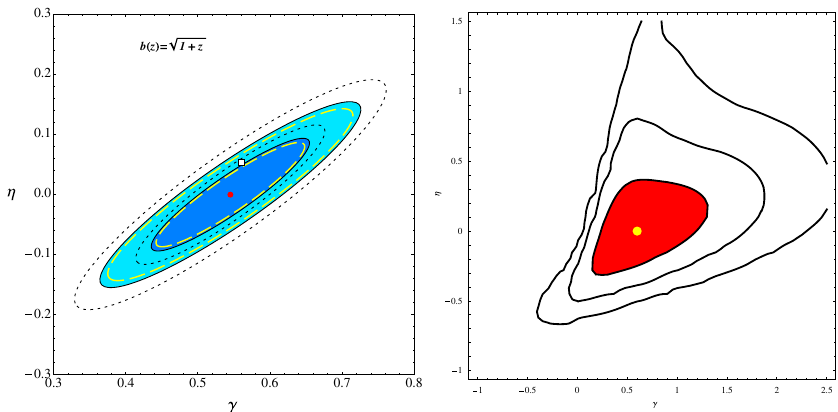
Fig. 23 η -parameterization. Left panel: 1 and 2 σ marginalized probability regions for the parameters γ and η in Eq. (I.8.6) relative to the reference case (shaded blue regions), to the optimistic case (yellow long- dashed ellipses) and to the pessimistic case (black short-dashed ellipses). The red dot marks the fiducial modelwhilethesquarerepresentsthecouplingmodel.Rightpanel:presentconstraintson γ and η